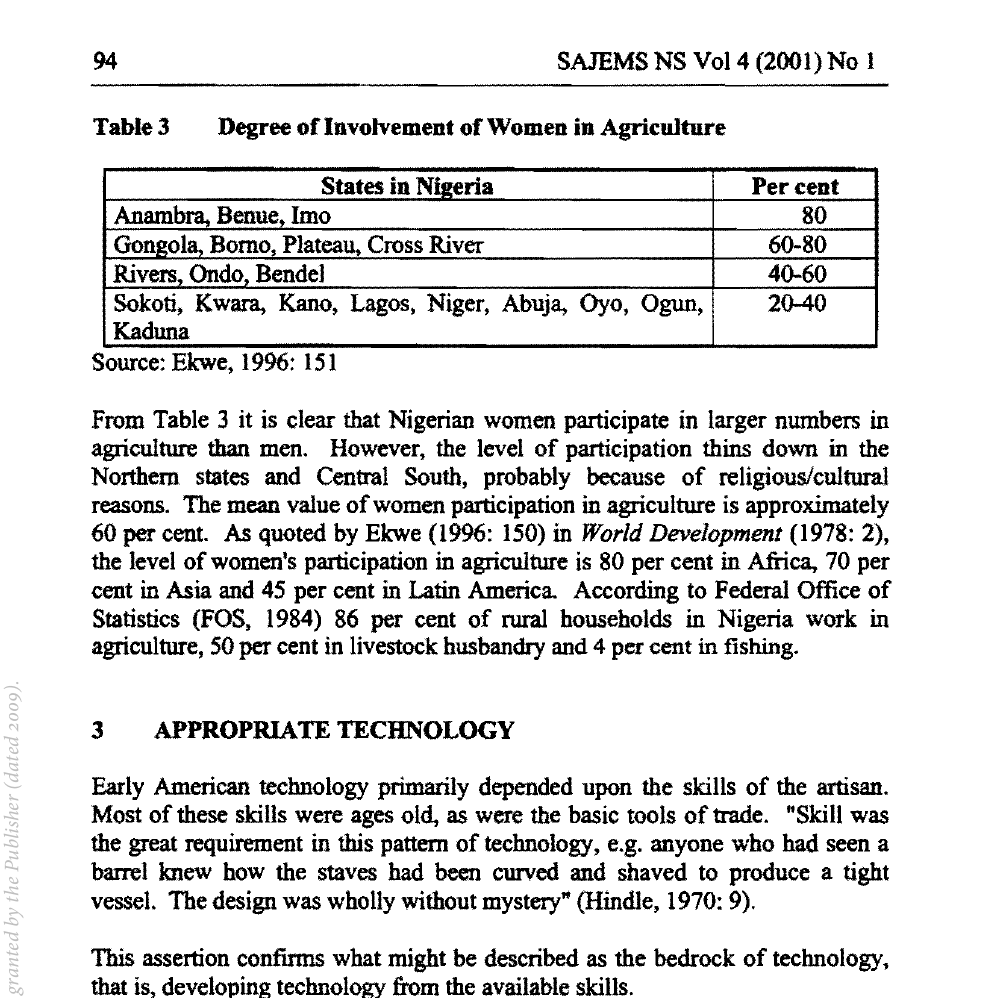
Degree ofInvolvement of Women in Agriculture States in Ni2eria PerceDt 80 Gon~ola, Bomo, Plateau, Cross River 60-80 Rivers Ondo Bendel